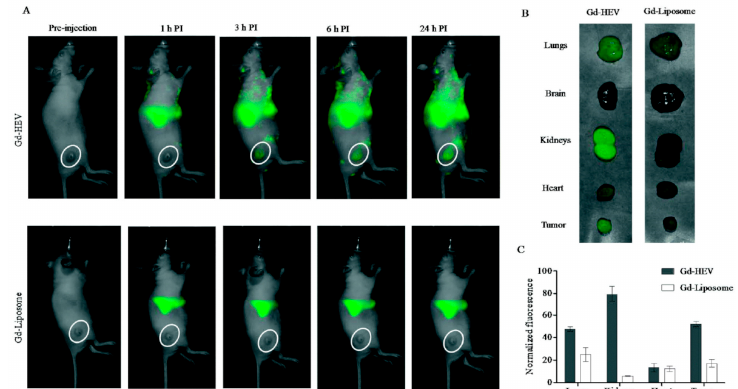
Figure 4. In vivo study by fluorescence bioimaging. ( A ) Time-dependent fluorescence images of mice injected with near-infrared DiR dye-labeled Gd-conjugated liposomes (Gd-HEVs) and Gd-liposomes, ( B ) bioaccumulation of Gd-HEVs and Gd-liposomes in organs of mice 24 h post-injection, and ( C ) quantification of fluorescence in organs harvested from Gd-HEV and Gd-liposome-treated mice. Fluorescence data were normalized by subtracting the fluorescence of the least fluorescent organ (brain) to picture the relative differences of fluorescence in different organs with respect to different particles. Reproduced from [95] (permission pending).